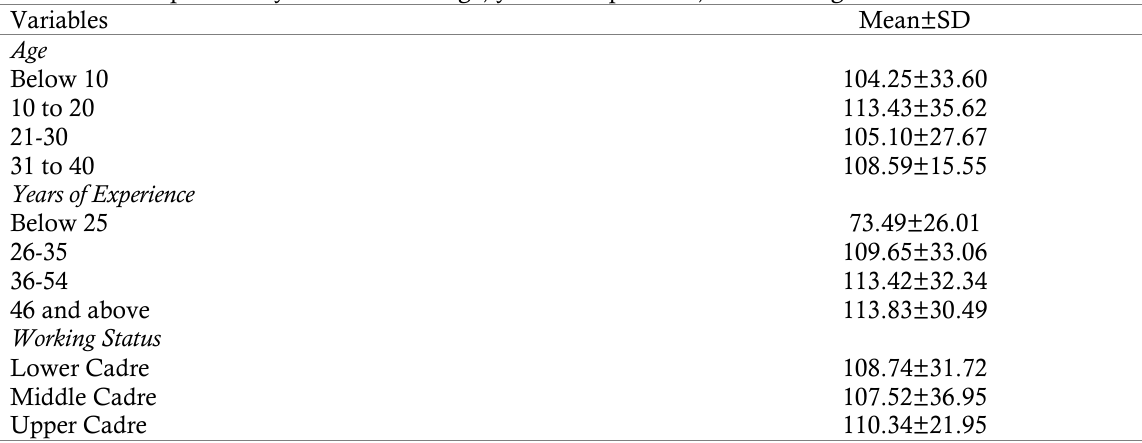
Figure 1. Demographical information of participants Table 1. Descriptive analysis of teachers’ age, years of experience, and working